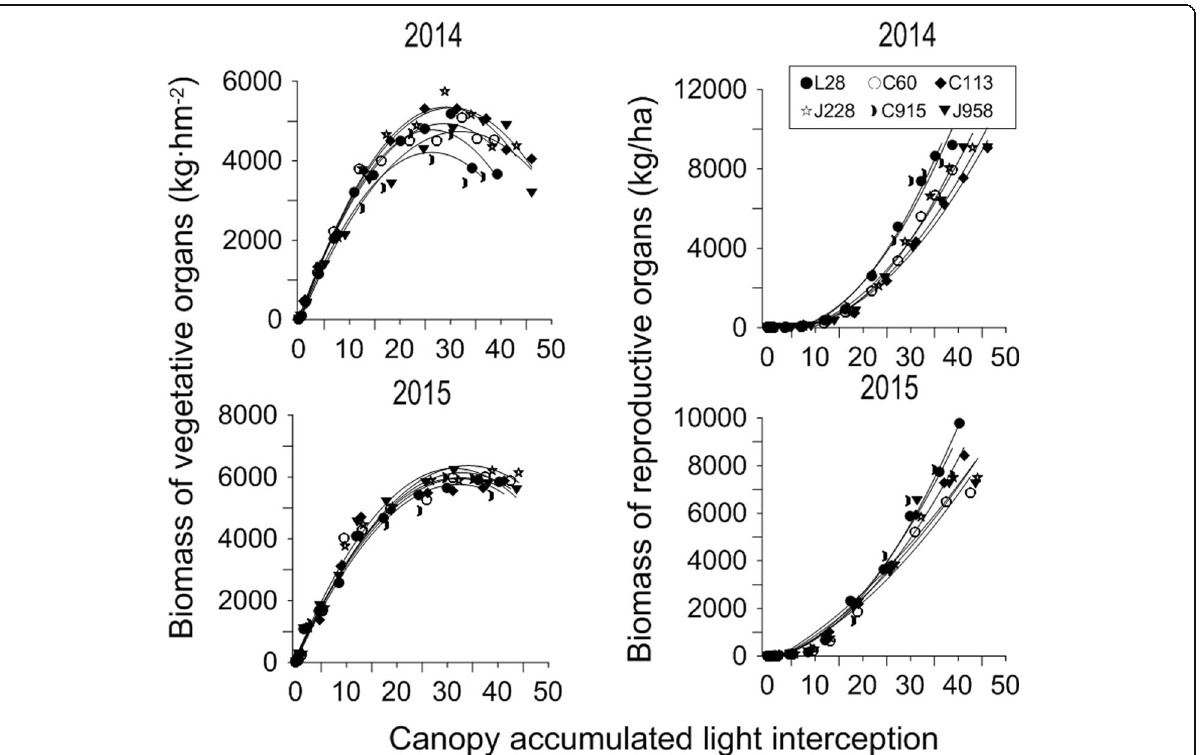
Fig. 7 Relationships of LI with vegetative biomass and reproductive biomass for six cotton varieties with different plant types in 2014 and 2015